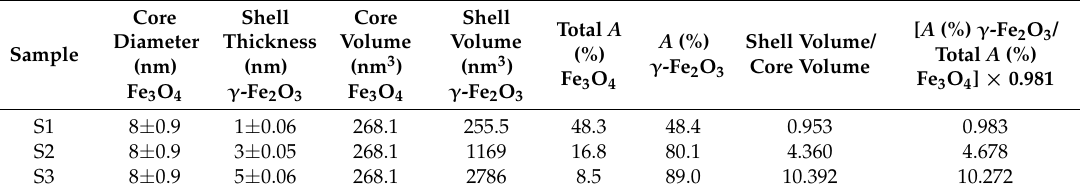
Table 2. The ratios of Shell volume/Core volume for the three different nanoparticle samples, and the ratios of the Mössbauer percentage area (relative intensity) of each subspectra [ A (%) γ -Fe 2 O 3 / A (%) Fe 3 O 4 ] multiplied by the factor 0.981 for the ratio of the concentration of Fe-atoms per unit volume in γ -Fe 2 O 3 and Fe 3 O 4 .